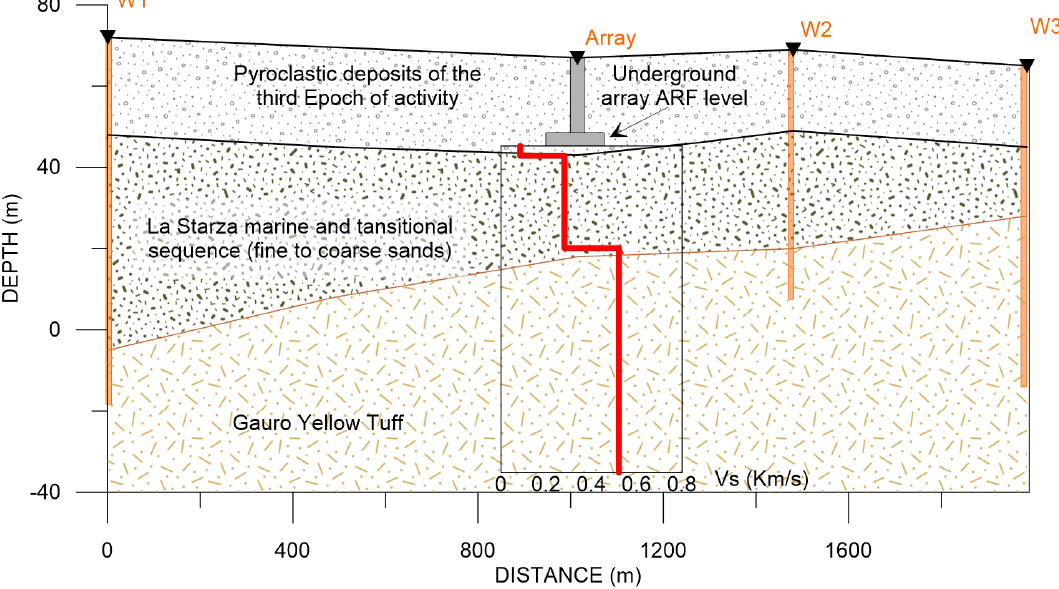
Figure 9. Geological section along the black line reported in the inset in Fig. 1, obtained from stratigraphic information coming from wells (orange squares in the zoom of Fig. 1) and from shear wave velocity model achieved from the joint